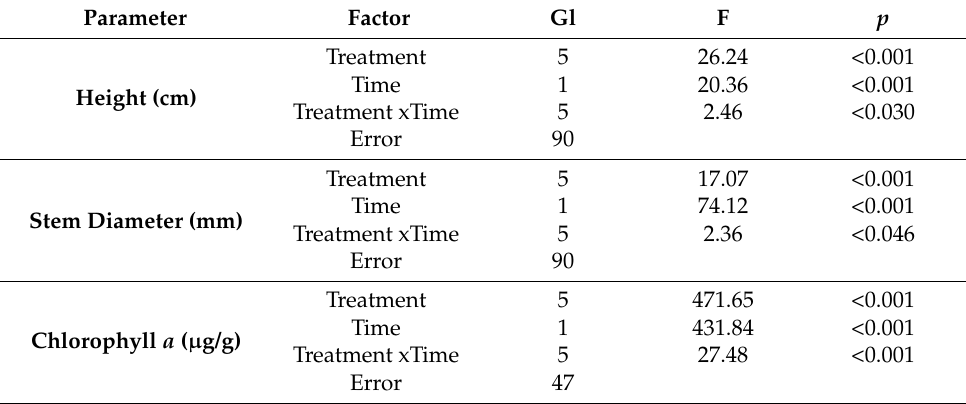
Table 3. Two-way ANOVA concerning growth in height, diameter, and concentration of chlorophyll in Rhizophora mangrove seedlings between treatments (control, 5%, 10%, 25%, 50%, and 100%) and exposure times (12 and 16 days) with a significance level of p < 0.05.